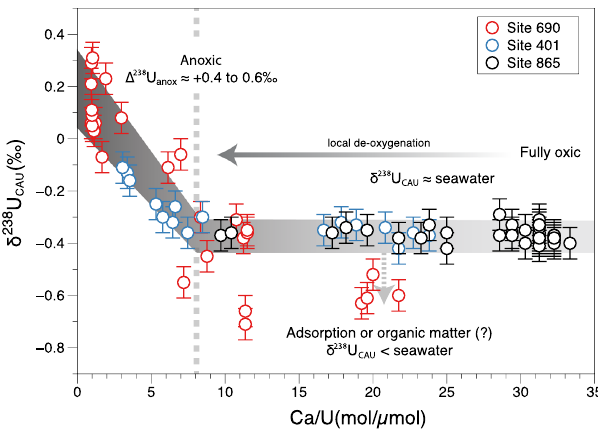
Fig. 2 Relationship of δ 238 U CAU and U concentrations. Note that U concentrations are expressed as Ca/U (inverted relative to Fig. 1) in order to emphasize the samples showing U enrichment (lower Ca/U) coupled to high δ 238 U CAU at Sites 690 (red circles) and 401 (blue circles). These samples demonstrate a near-linear relationship when Ca/U < 8 mol/ µ mol, which are consistent with a Δ 238 U anox of up to ~ + 0.6 ‰ relative to inferred δ 238 U sw . Data from Site 865 (black circles) and pre-PETM data from Site 401 that plot along the fl at array of Ca/U likely record δ 238 U sw . δ 238 U CAU values below inferred δ 238 U sw at Site 690 could be caused by the adsorption of isotopically light U directly to calcite or repartitioned during organic matter re-mineralization. Error bars for δ 238 U CAU represent the external reproducibility of the NIST-SRM 1d limestone standard (±0.06 ‰ , 2